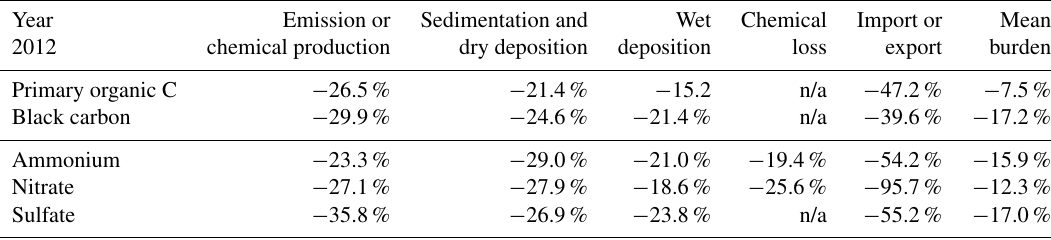
Table 16. Annual budget for the year 2012 of the total mass of aerosols. The terms corresponds to the relative difference between the reference simulation and the sensitivity test. A negative value means the value is smaller in the test simulation.